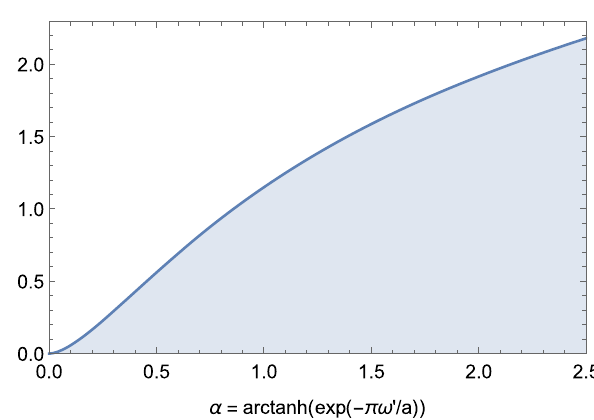
Fig. 13 Upper bound on E F (ρ M , II